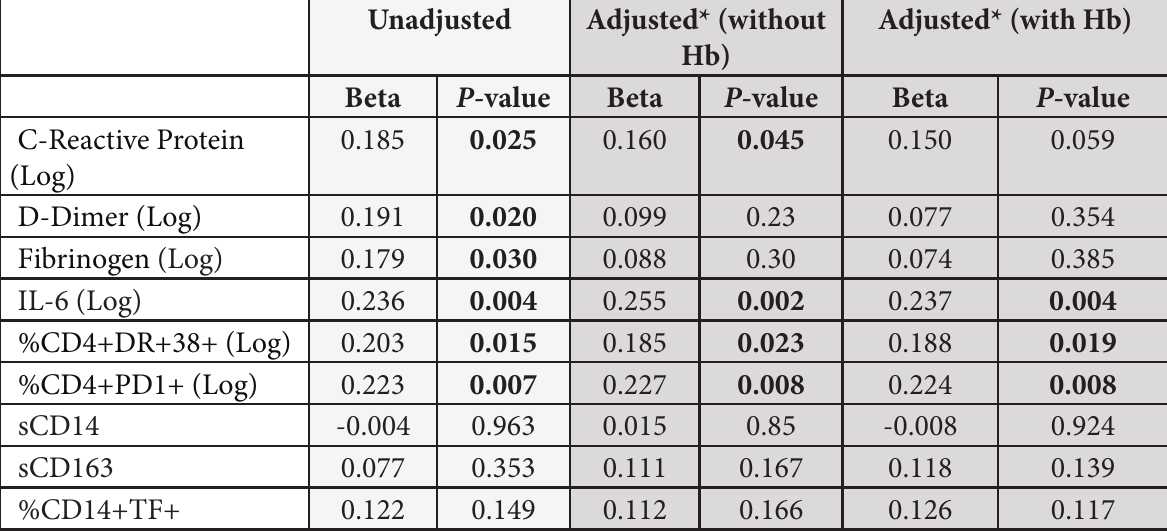
Table 4. Unadjusted and adjusted linear regression models of the relationship between biomark- ers of inflammation and immune activation/exhaustion and log RDW.